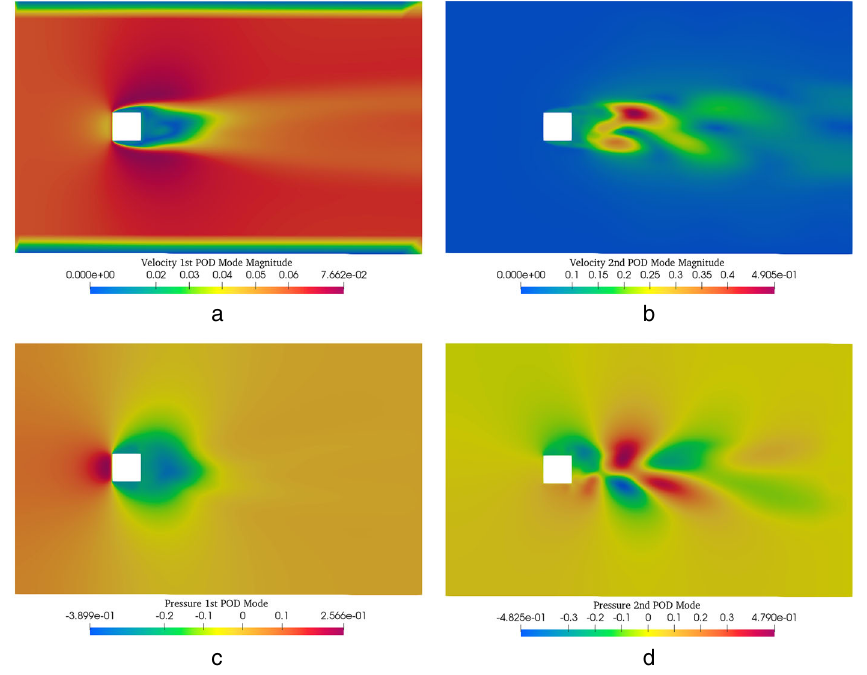
Fig. 12 The first two POD modes of the velocity and pressure, a 2 D cross-sectional view of the domain at x 3 = L is shown. (a) The first velocity POD mode. (b) The second velocity POD mode. (c) The first pressure POD mode. (d) The second pressure POD mode